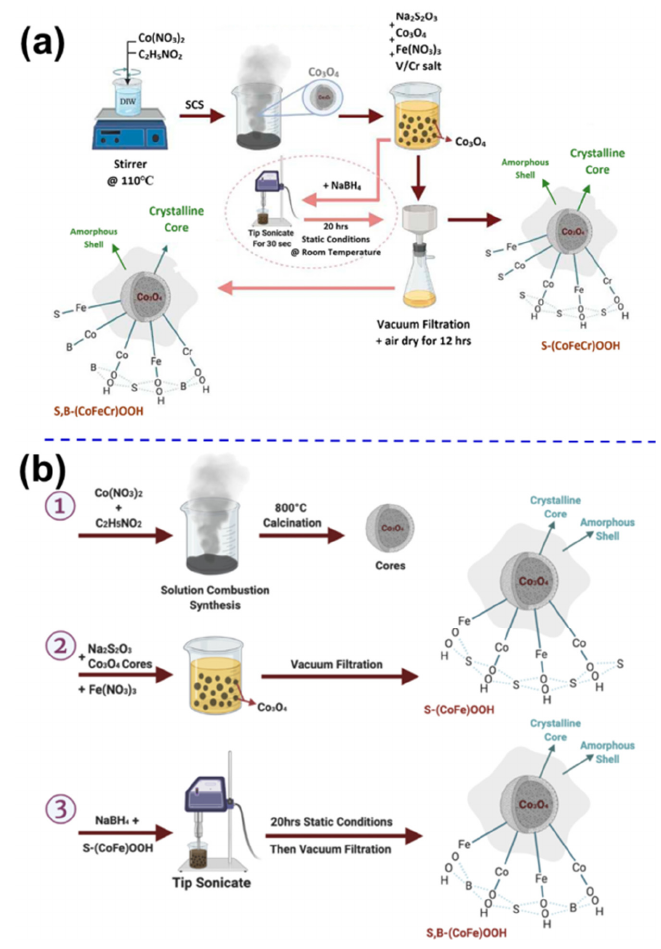
Figure 6. ( a ) The preparation of S, B-(CoFeCr)OOH and S, B-(CoFeV)OOH [37]; ( b ) preparation schematic of S,B-co-doped CoFe oxyhydroxide [38].